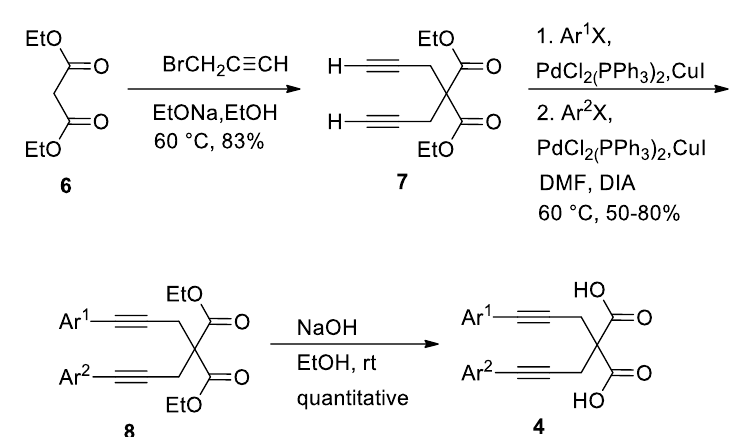
Table 2. Substrate scope for the gold(I)- catalyzed spirodilactonization to γ -arylidenespirobislac- tones 5 a,b